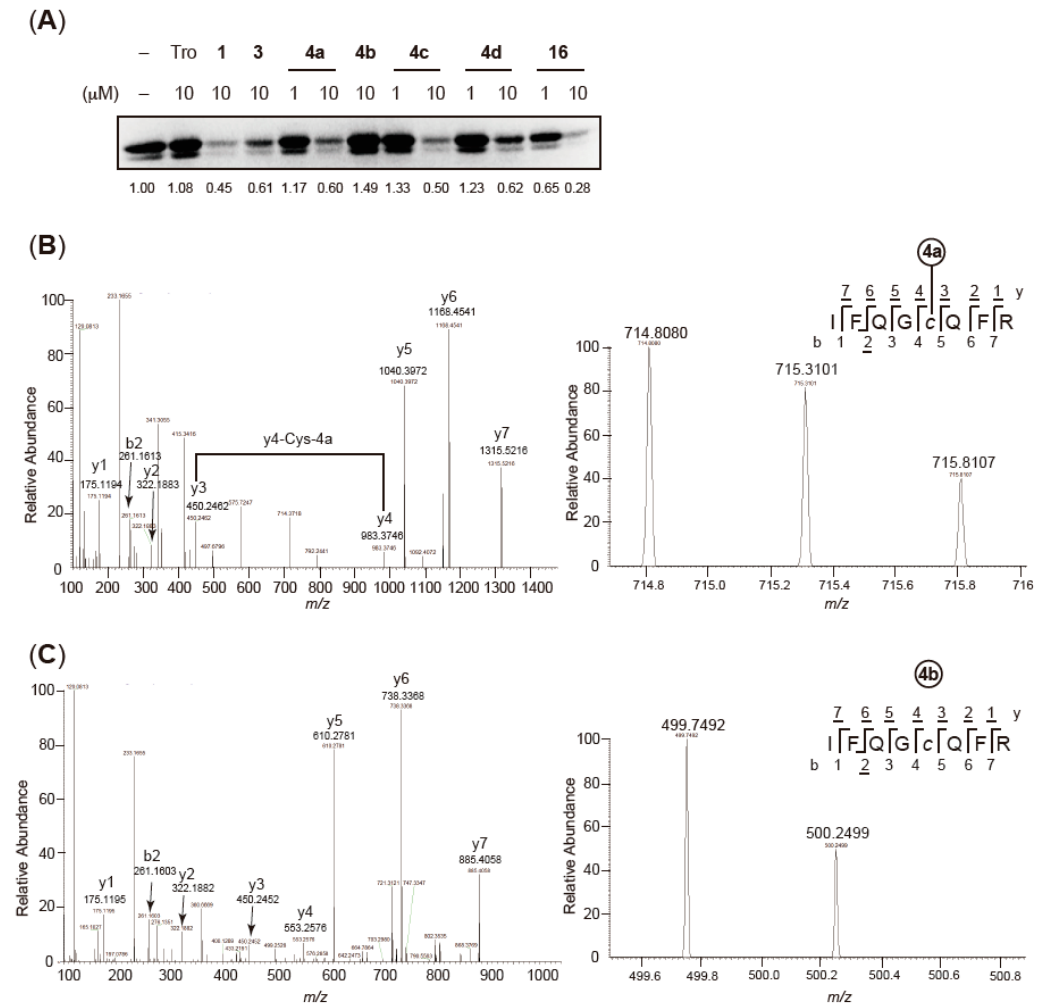
Figure 3. Assessment of the abilities of the synthesized compounds to form a covalent bond with the Cys285 residue in the PPAR γ LBD. ( A ) PPAR γ LBD recombinant protein was incubated with the vehicle (0.1% DMSO, shown as –), troglitazone (shown as Tro), 1 , 3 , 4a , 4b , 4c , 4d , or 16 , and the free cysteine residue was detected by the rhodamine-maleimide assay. ( B ), ( C ) Detection of covalent binding of 4a to Cys285 in the PPAR γ LBD by ESI-MS / MS analysis. Fragmentation pattern of peptide IFQGCQFR was obtained from the trypsin digest. The calculated y- and b-ions of this peptide with observed ions underlined and the native or modified peptides detected in chromatogram are shown. The spectrum in ( B ) shows the adduct of 4a with Cys285 residue in the PPAR γ LBD; in contrast, in panel ( C ), no adduct of 4b is observed.